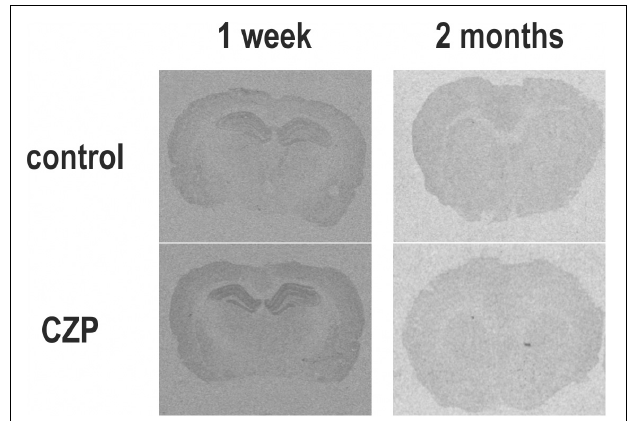
FIGURE 5 | Autoradiograms illustrate the distribution of binding to NMDA receptors labeled with [ 3 H]-MK-801 in brain sections from the dorsal hippocampus (–3.3 mm relative to bregma according to Paxinos and Watson, 1986; left panels) and striatum (0.2 mm relative to bregma according to Paxinos and Watson, 1986; right panels) of rats treated with vehicle (C) or clonazepam (CZP), at 1 week (1 w) and 2 months (2 mo) posttreatment. High binding appears as black areas. Compared to controls, animals exposed to CZP exhibited increased [ 3 H]-MK-801 binding in the hippocampus 1 week after CZP cessation, whereas 2 months later, binding was lover in the cingulate and frontal cortex and caudate